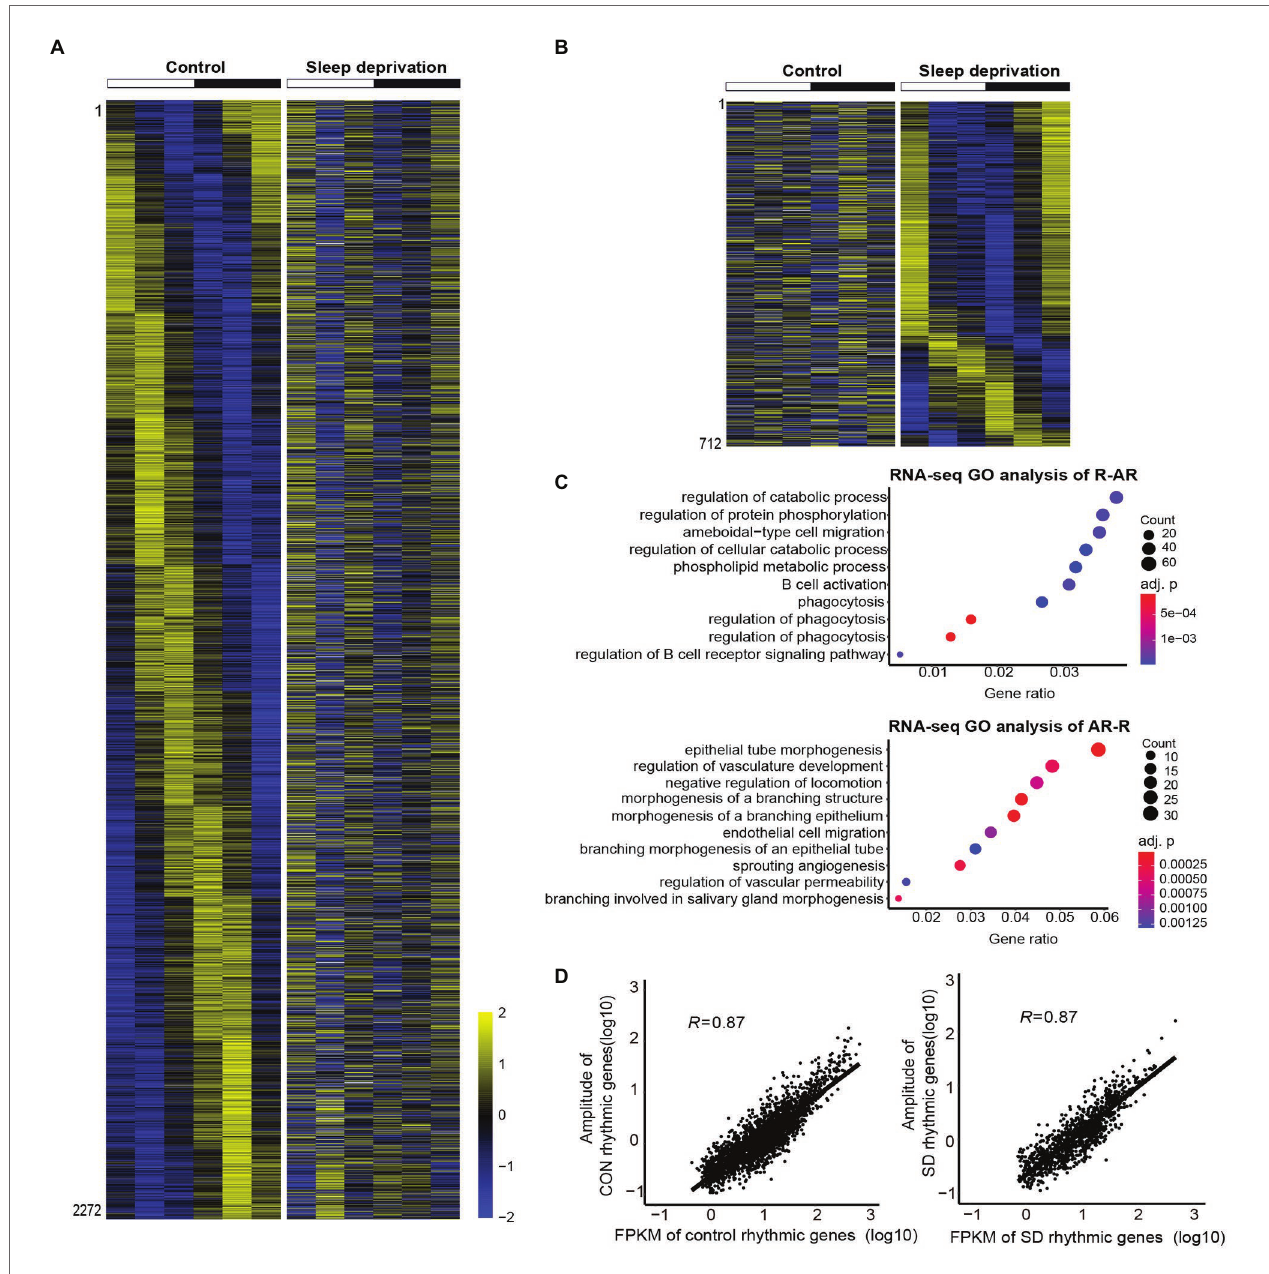
FIGURE 2 | Gene ontology (GO) analyses on the genes that altered rhythmic expression after sleep deprivation. (A,B) Heatmap of cyclic mRNA expression in the mouse lung. The majority of rhythmically expressed genes in control condition lost oscillation after sleep deprivation ( A , n = 2,272, R-AR category in Figure 1A ). There were many genes that gained circadian oscillation expression after sleep deprivation ( B , n = 712, AR-R category in Figure 1A ). High expression is displayed in yellow ( z -score > 1) and low expression in blue in the heatmaps ( z -score < 1). (C) GO analysis for functional classes in which circadian disrupted genes in the control and SD conditions were enriched. (D) Amplitude of rhythmic genes was correlated with mean expression in both control ( n = 2,590, R = 0.87) and SD ( n = 1,030, R = 0.87)